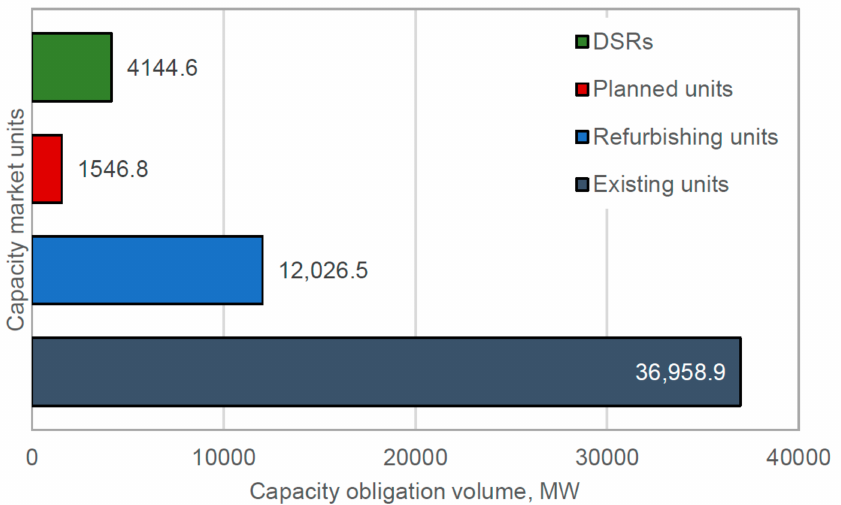
Figure 15. Capacity obligation volume contracted in main capacity auction for 2021–2025 delivery years–break down by actual status of capacity market units. Source: Own analysis based on